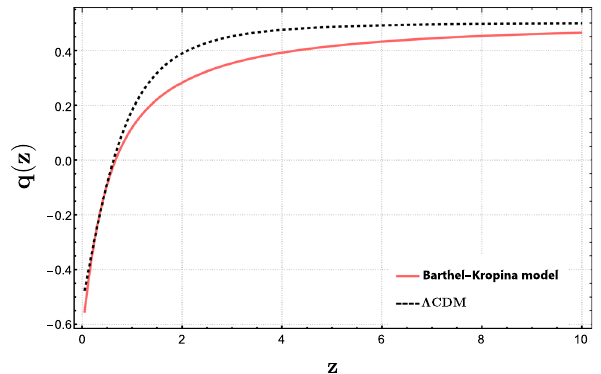
Fig. 7 The evolution of the snap parameter s as a function of the red- shift z in the Barthel–Kropina and (cid:2) CDM